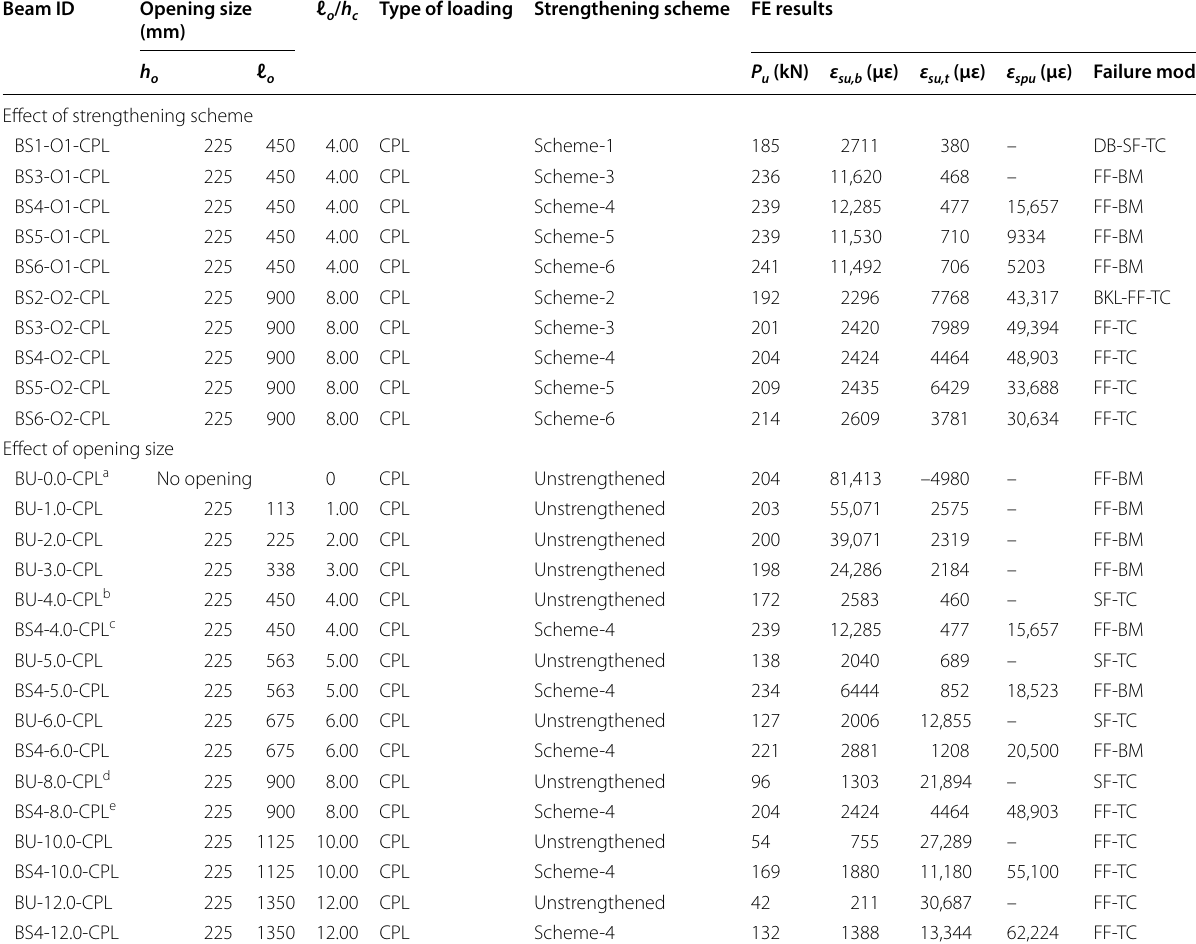
Table 5 Details and FE results of beams used in the parametric